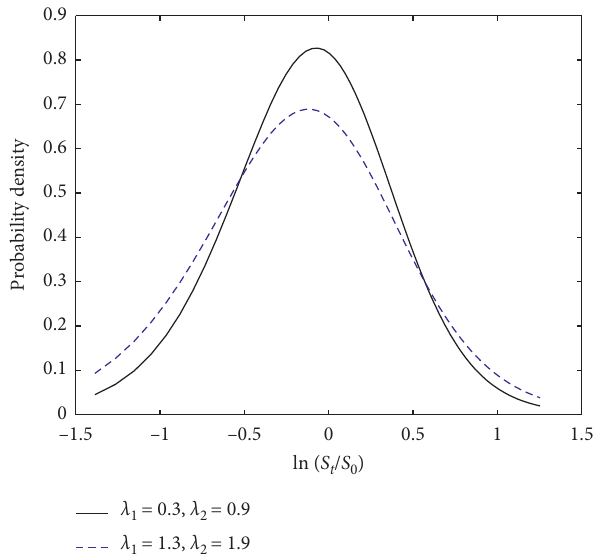
Figure 6: Probability density function with different jump in- and λ . tensities λ 2 3